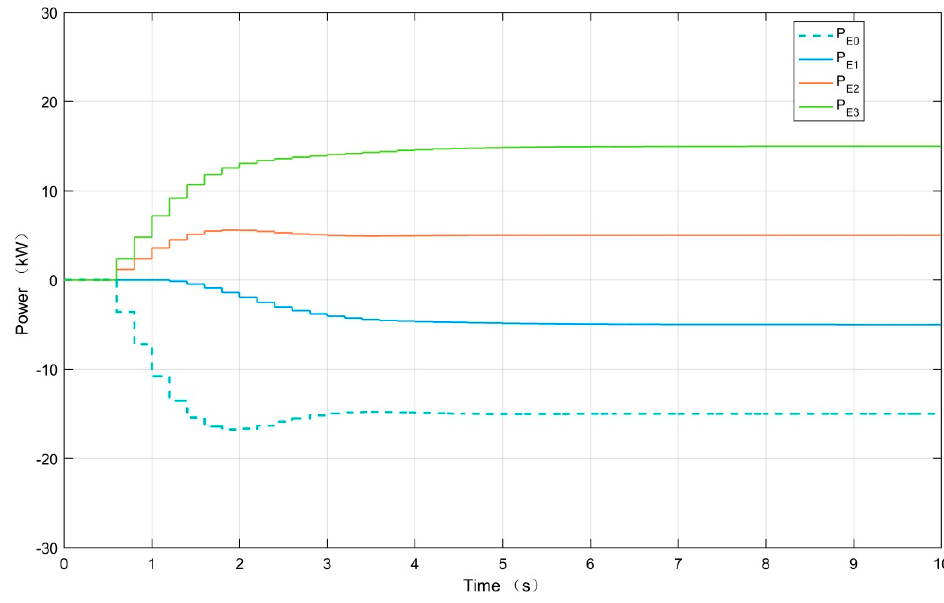
Figure 13. Exchange power of modules ( τ = 0.3 s, T = 0.2 s).